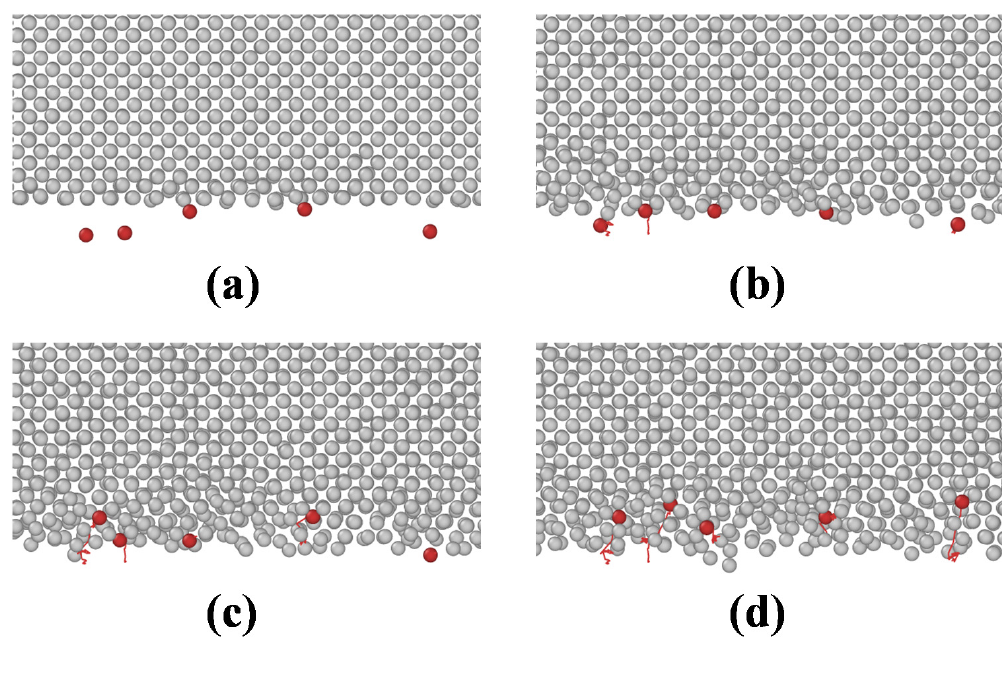
Figure 6. Particle trajectories of labeled Cu atoms at different alloying temperatures: ( a ) 300 K, ( b ) 900 K, ( c ) 1100 K, and ( d ) 1300 K.